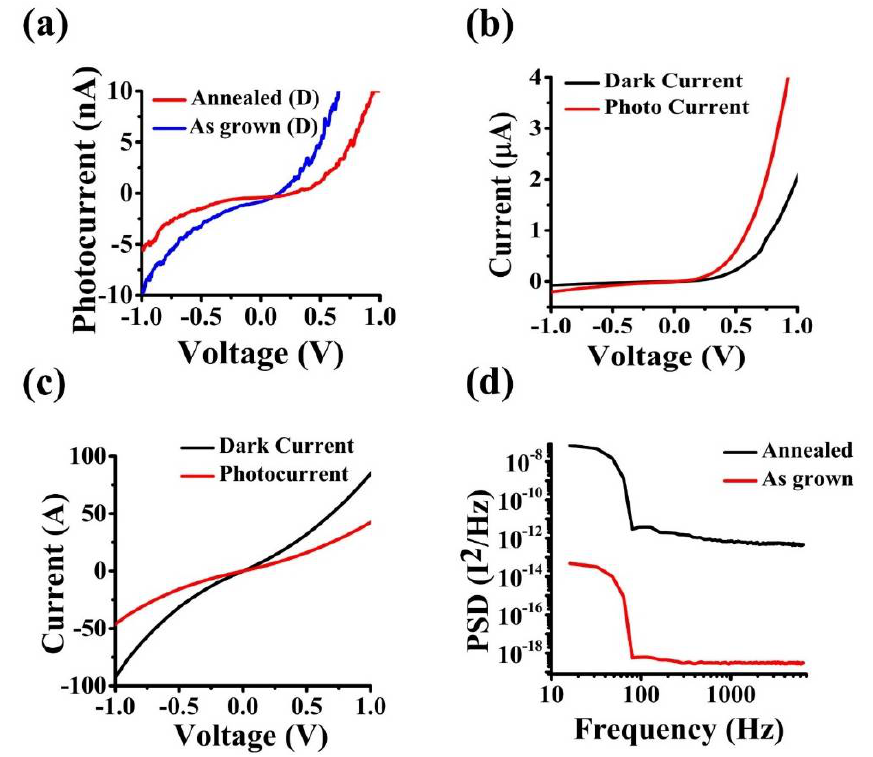
Figure 4. ( a ) SNW I-V characteristics of annealed and as-grown doped nanowires under 860 nm illumination. Ensemble NW IV characteristics of ( b ) as grown GaAs: Te NWs and ( c ) annealed GaAs: Te NWs, and ( d ) low-frequency noise (LFN)